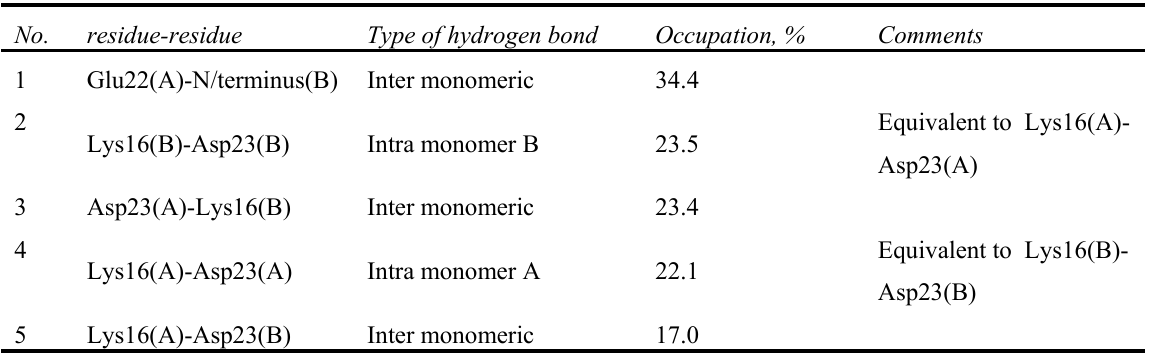
Table 2. The five most frequent hydrogen bonds.